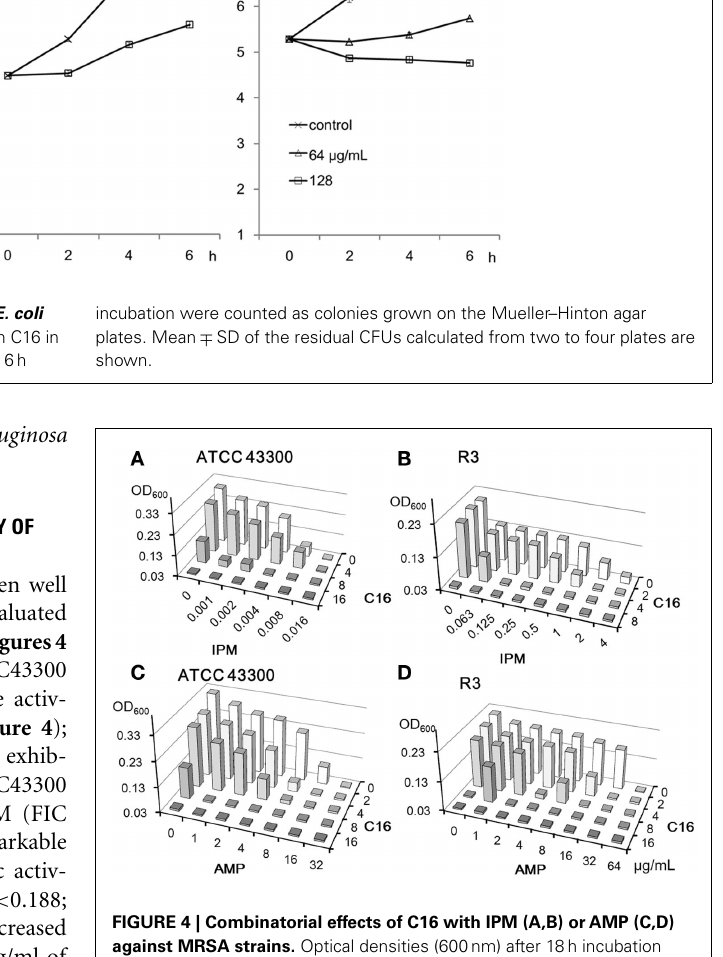
FIGURE 4 | Combinatorial effects of C16 with IPM (A,B) orAMP (C,D) against MRSA strains. Optical densities (600nm) after 18h incubation were determined by the checkerboard